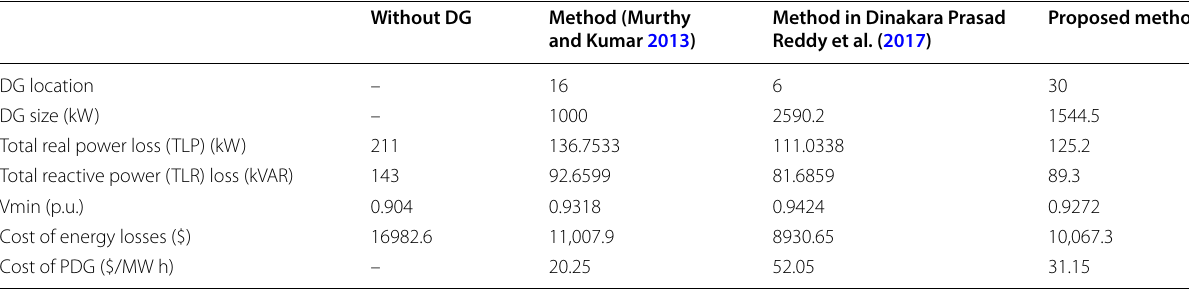
Table 5 Results for 33-bus system with DG at upf